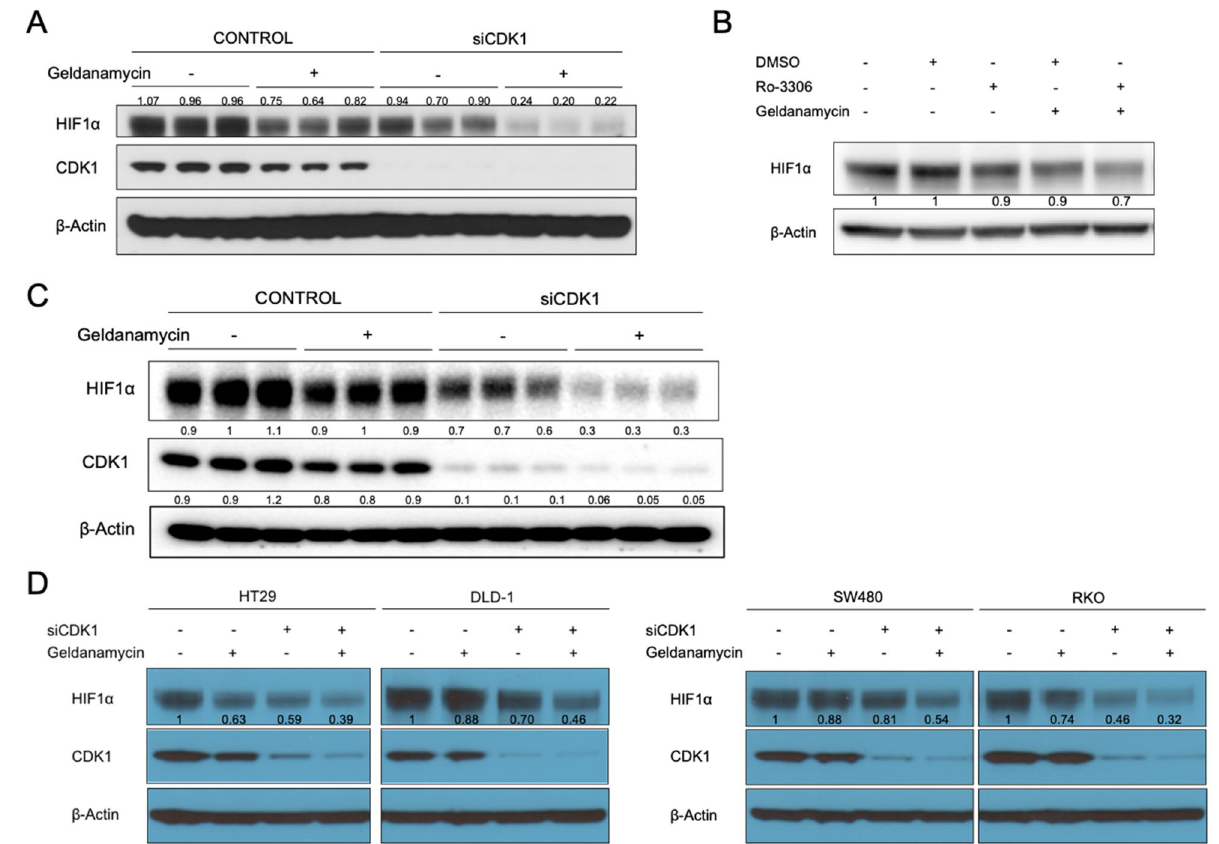
Figure 2. Dual inhibition of CDK1 and HSP90 robustly reduces the level of HIF1α. ( Α ) HCT116, ( C ) HCT116 p53 −/− cells or ( D ) other colorectal cell lines were treated with control or CDK1 siRNA for 48 h, followed by treatment with DMSO or geldanamycin (2 μM) under hypoxia (0.5% O 2 ) for 6 h. ( B ) Cells were treated with Ro-3306, geldanamycin, or the combination of both for 6 h under